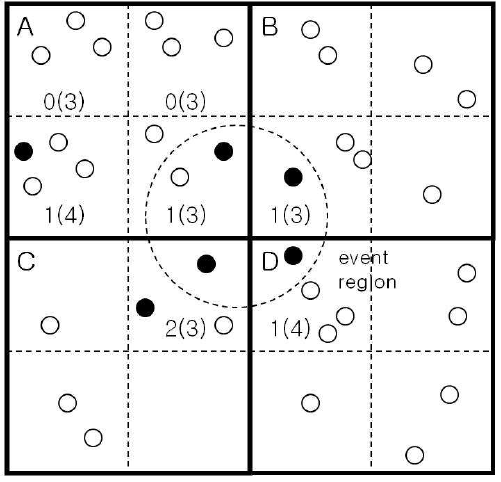
Figure 2. An illustration of the proposed grid-based event